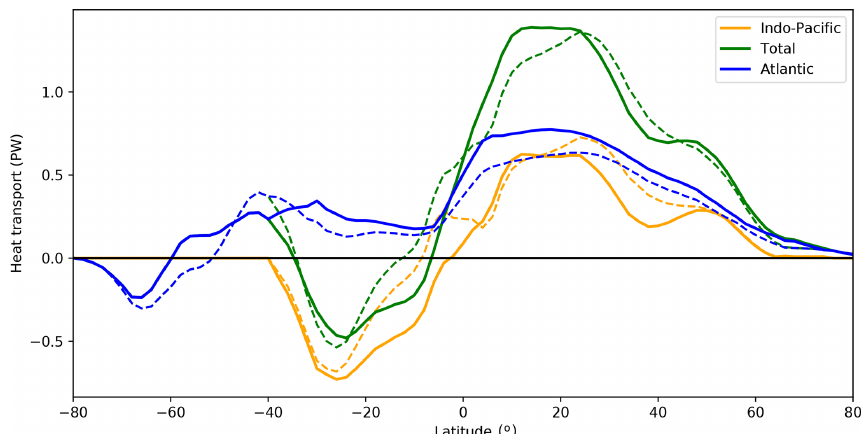
Figure 12. Meridional heat transport (PW) as a function of latitude for the global ocean, Atlantic and Indo-Pacific, averaged over the control integration. A five-grid-point smoother has been applied. Solid (dashed) lines show the meridional heat transport for the L35 (L20)